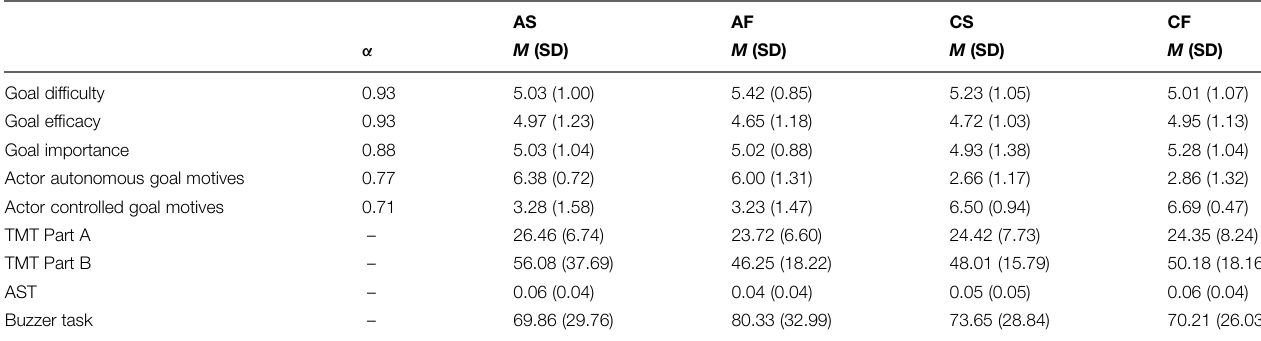
TABLE 1 | Cronbach’s internal reliabilities and descriptive statistics for study variables by